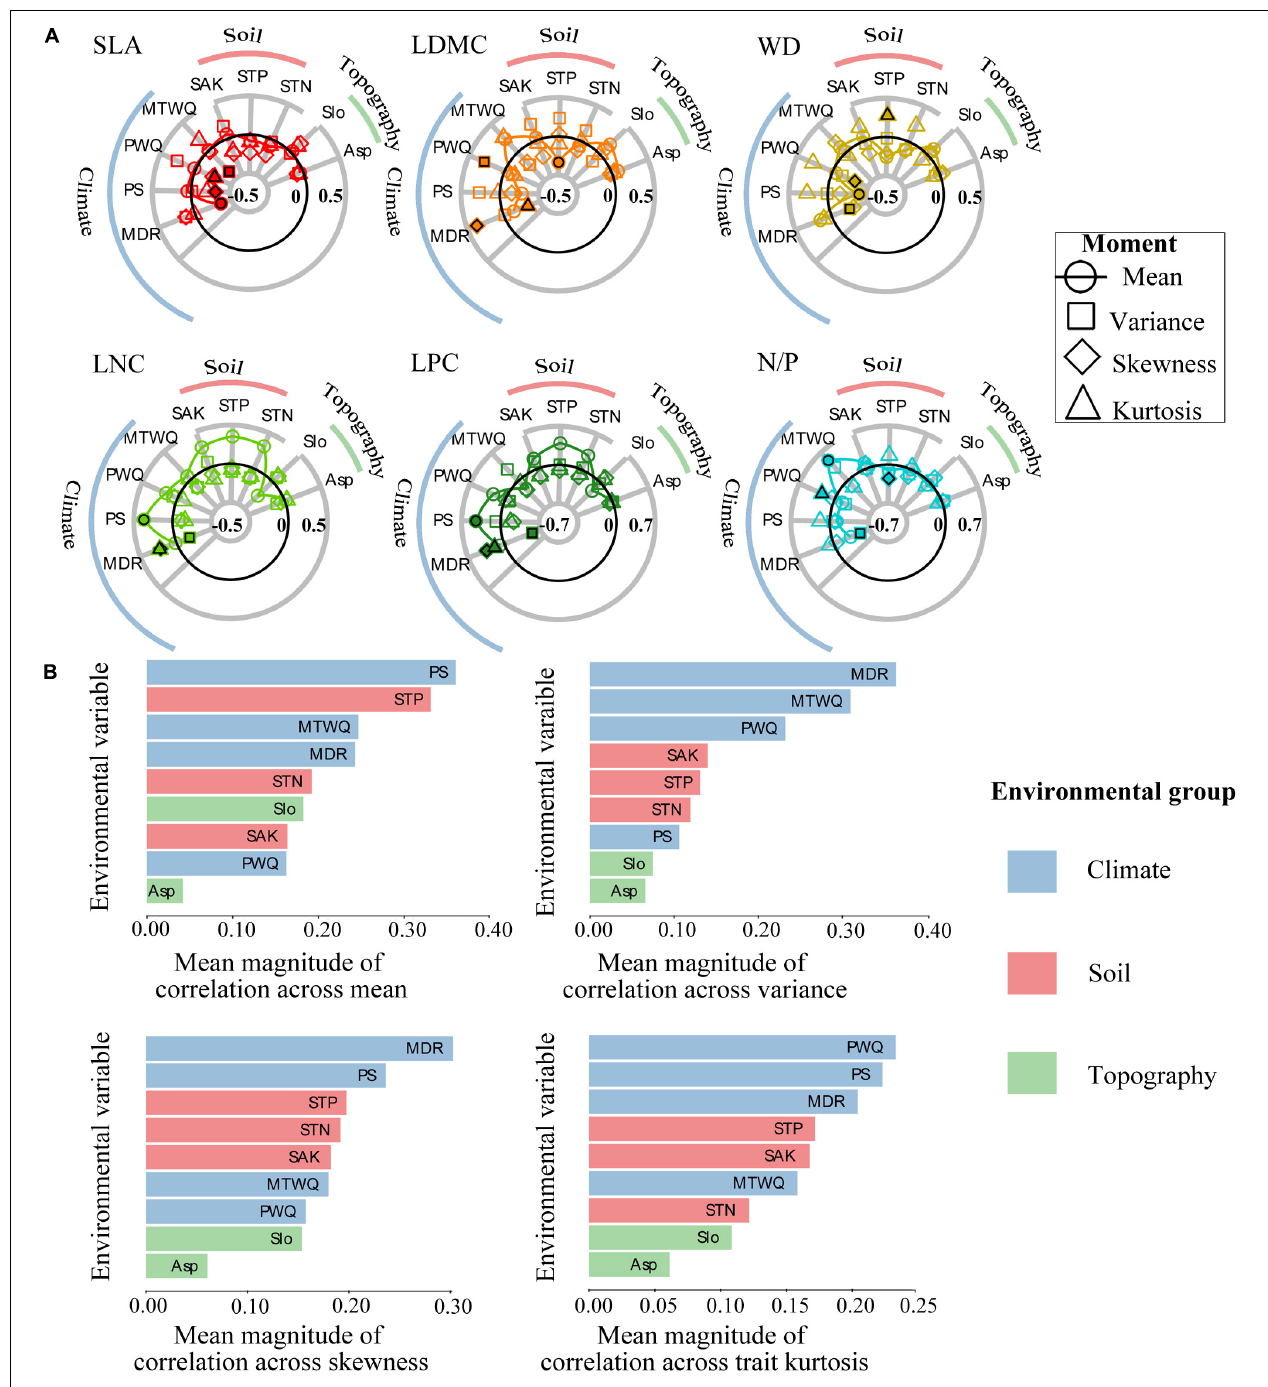
FIGURE 2 | Relationships between the community-weighted moments of individual functional traits and the environmental variables across all forest plots. (A) Radar plots showing all trait moment–environment correlations. Each symbol represents a different trait moment, and its position along the radial axis indicates the strength of correlation between trait moment and a given environmental variable. The solid black line represented zero correlation, the region inside (outside) this line represents negative (positive) correlations. Filled shapes highlight the environmental variables that are most strongly correlated with each of the four trait moments. (B) Histograms showing mean magnitudes (absolute values) of all correlations between all trait moments and each environmental variable. Environmental variables are abbreviated as follows: mean temperature of wettest quarter (MTWQ), mean diurnal range (MDR), precipitation of warmest quarter (PWQ), precipitation seasonality (PS), soil total nitrogen (STN), soil total phosphorus (STP), soil available potassium (SAK), slope (Slo), aspect (Asp). Functional traits are abbreviated as follows: leaf dry matter content (LDMC), leaf nitrogen concentration (LNC), leaf phosphorus concentration (LPC), leaf nitrogen/phosphorus ratio (N/P), specific leaf area (SLA), wood density